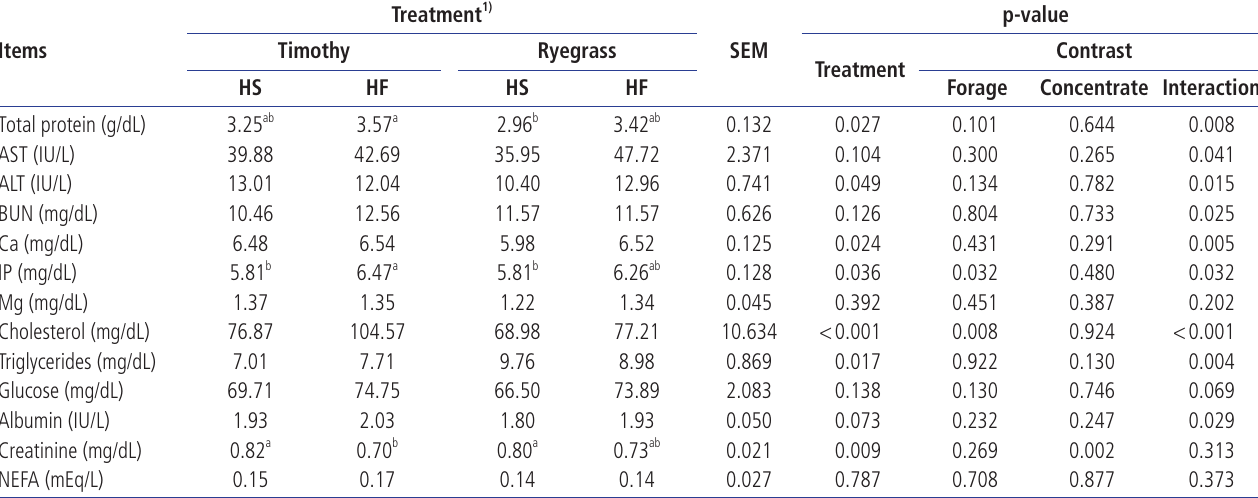
Table 5. Effect of the quality of forage and concentrate mix on blood metabolites in Hanwoo calves (n = 12)